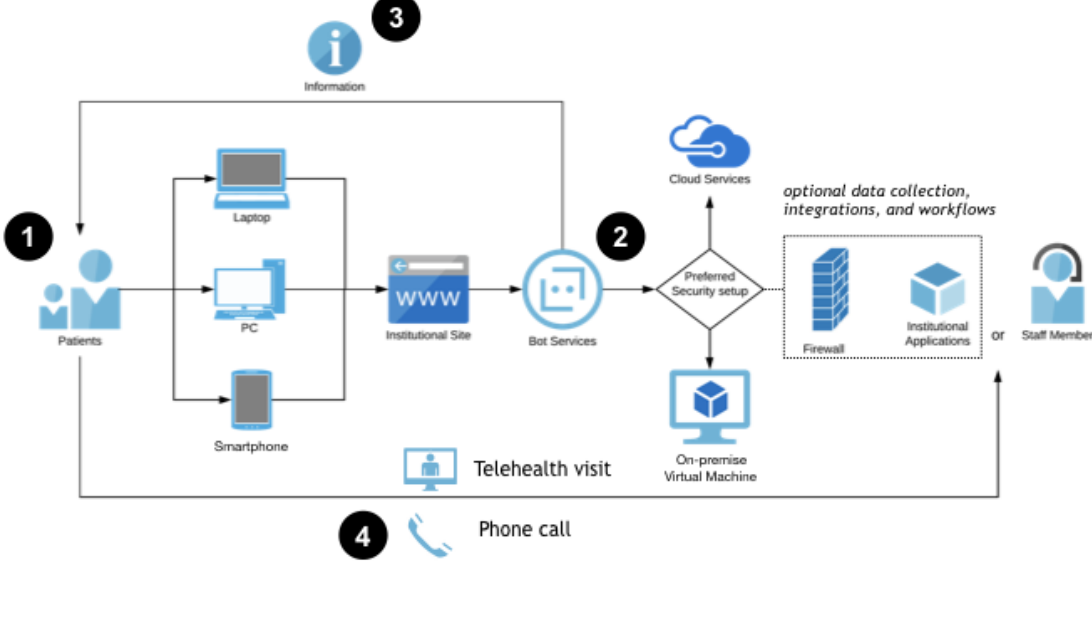
Figure 2. A chatbot network diagram: patient-initiated approach. This diagram illustrates a generic architecture and workflow for a simple chatbot that is hosted outside the institution’s secure computing environment. 1) Patient uses a personal device to access the institution’s website from a link they receive in a text, email, or secure message. 2) The chatbot interacts with the patient and stratifies them according to the screening algorithm. 3) The chatbot provides the patient with education, resources, tips, and specific instructions on next steps. 4) The patient reaches out to the hospital via phone or telehealth as instructed by the chatbot. Integration with hospital systems is possible for data collection and workflow management, but not required.